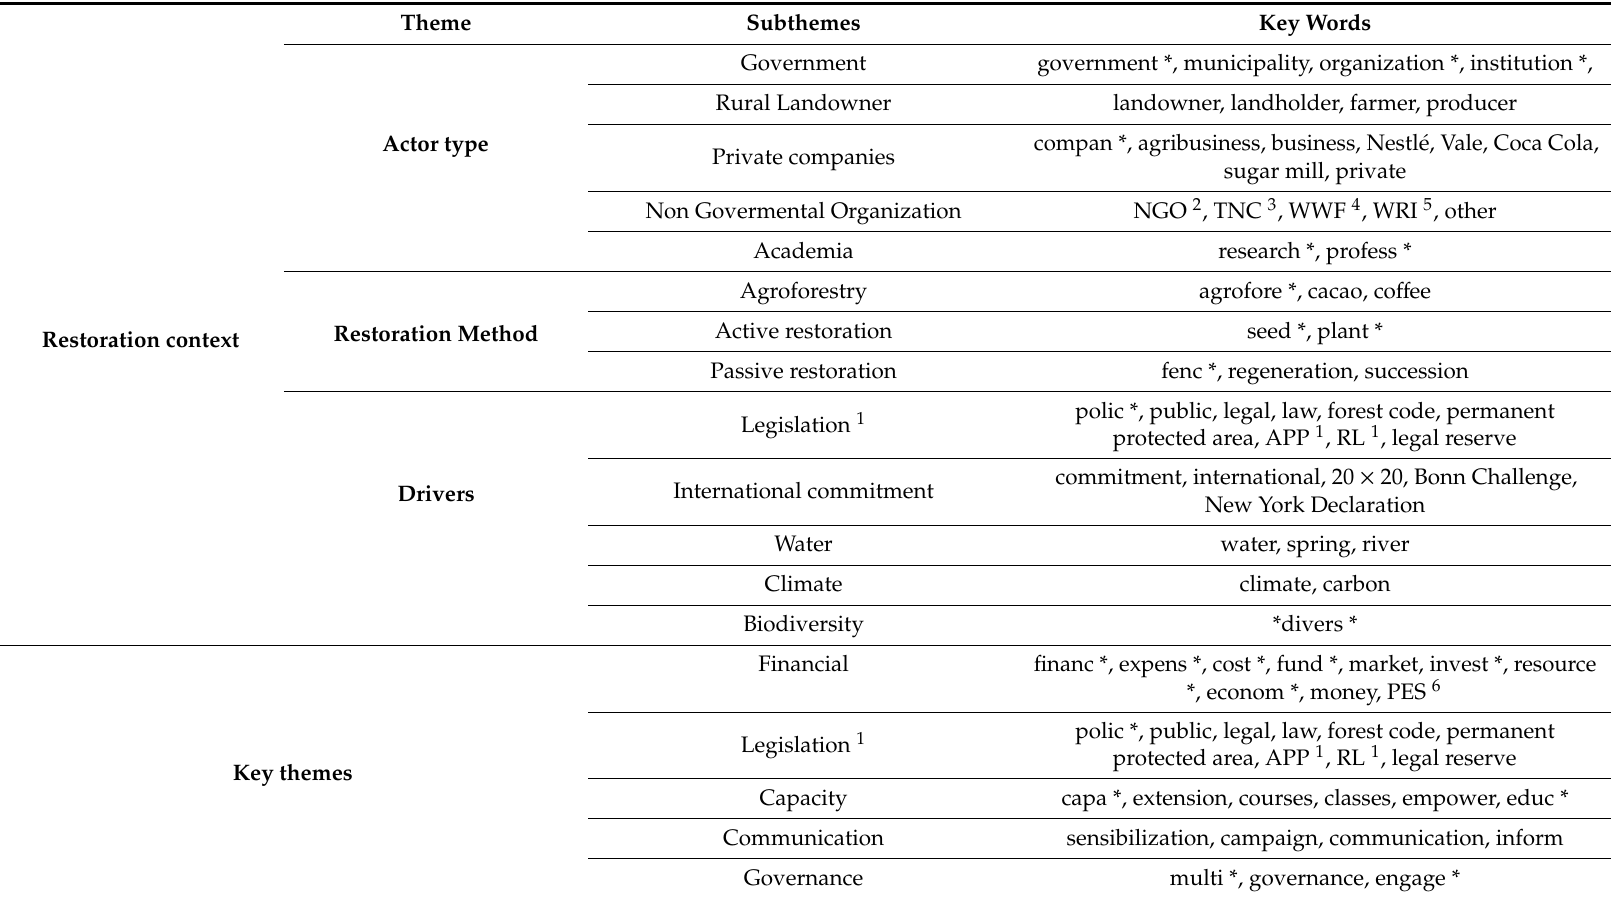
Table 4. Coding structure by themes and subthemes. The table also contains the key words for the lexical search. Key themes were employed for grouping barriers and strategies for increasing the scale of forest restoration